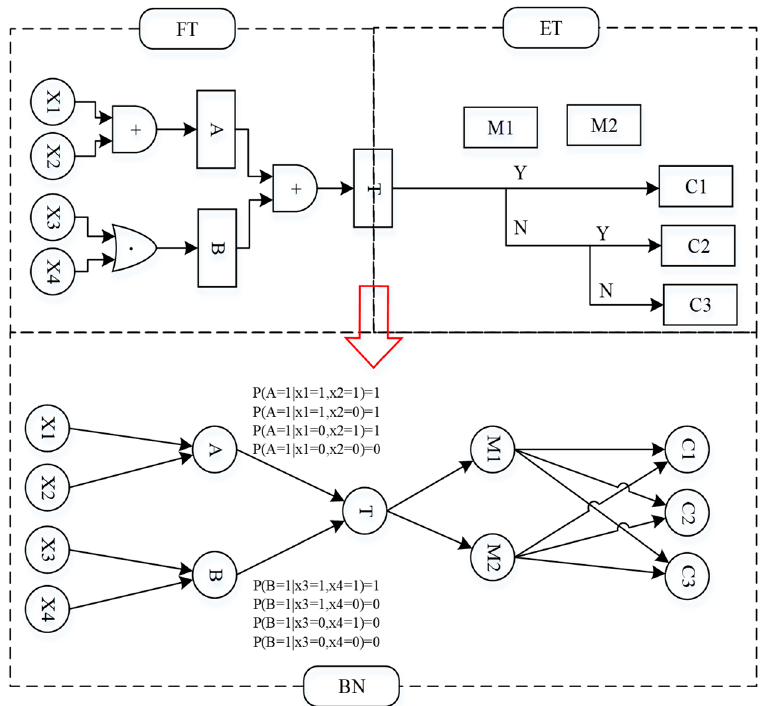
Figure 4. Transformation of the bow-tie model into a Bayesian network